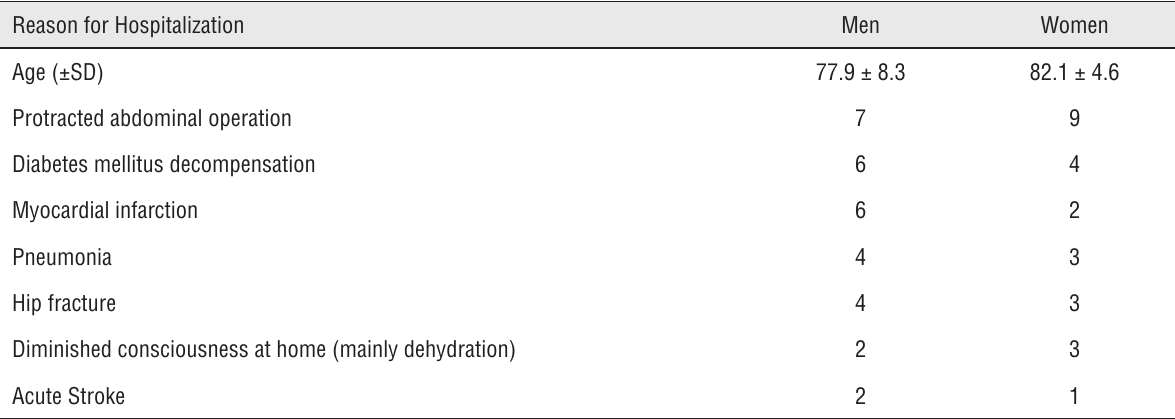
Table 1 - Demographics of patients and main clinical reason for the admittance to the hospital before having urological evaluation and diagnosed as acute urinary retention after hospitalization.